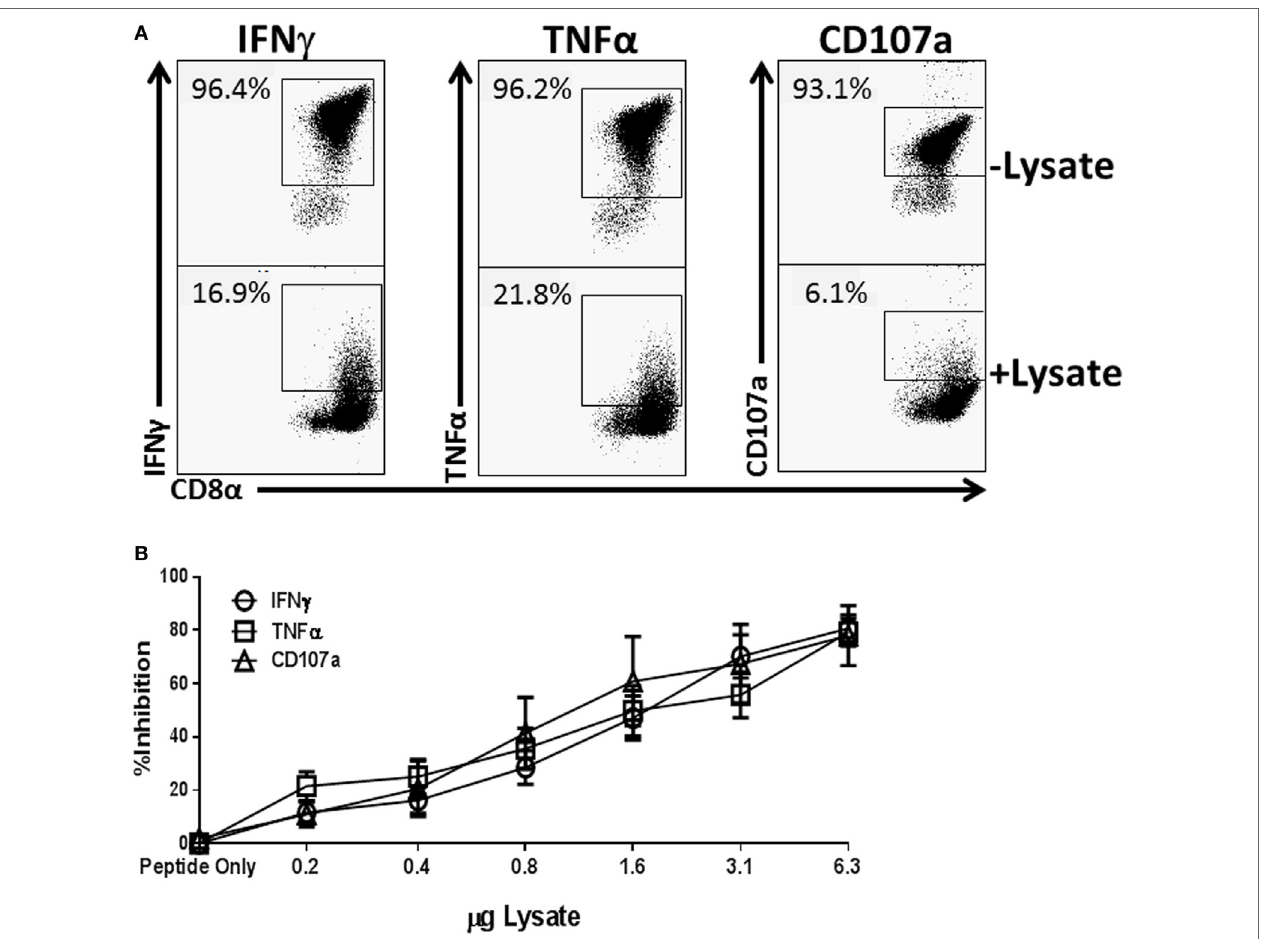
FigUre 1 | Treatment of NP-specific CD8 + cytotoxic T lymphocyte (CTL) with EF3030-derived lysate inhibits the production of IFN γ and tumor necrosis factor α (TNF α ) and the release of cytolytic granules. NP 147–155 -specific CTL was stimulated with peptide in the presence of increasing amounts of Spn lysate. Anti-CD107a antibody was included in the stimulation phase to identify cells releasing lytic granules. Following stimulation, cells were stained for CD8, IFN γ , and TNF α . Data shown are pregated on live CD8 + CTL. The percent inhibition refers to loss of the effector function noted in the legend. (a) Representative flow plots. (b) Averaged data ± SEM from eight independent experiments assessed using two independently generated NP-specific CTL